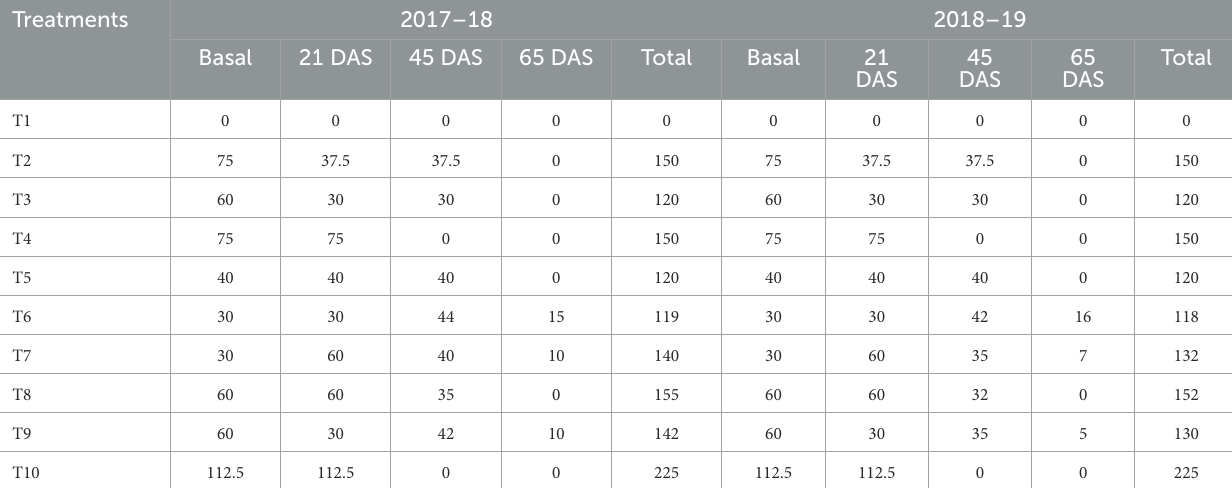
TABLE 3 Nitrogen application at various growth stages under different